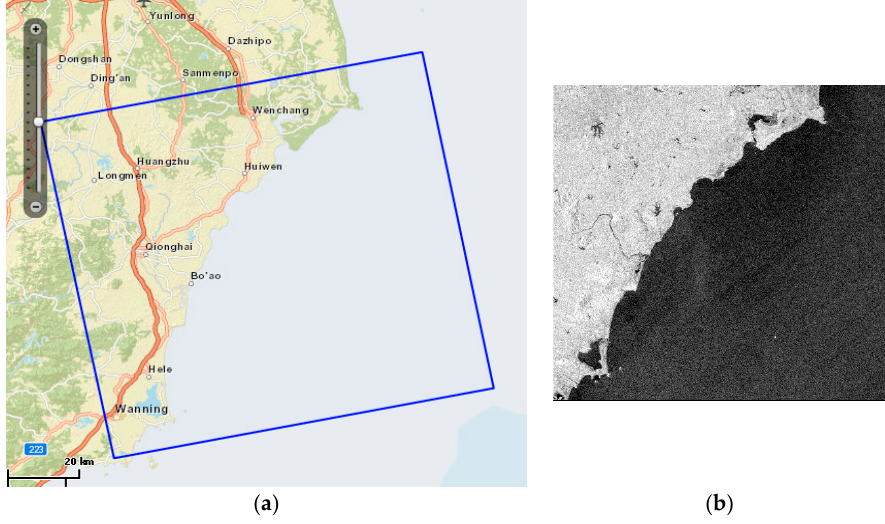
Figure 13. SAR image: ( a ) The administrative division map ( b ) The original SAR image.